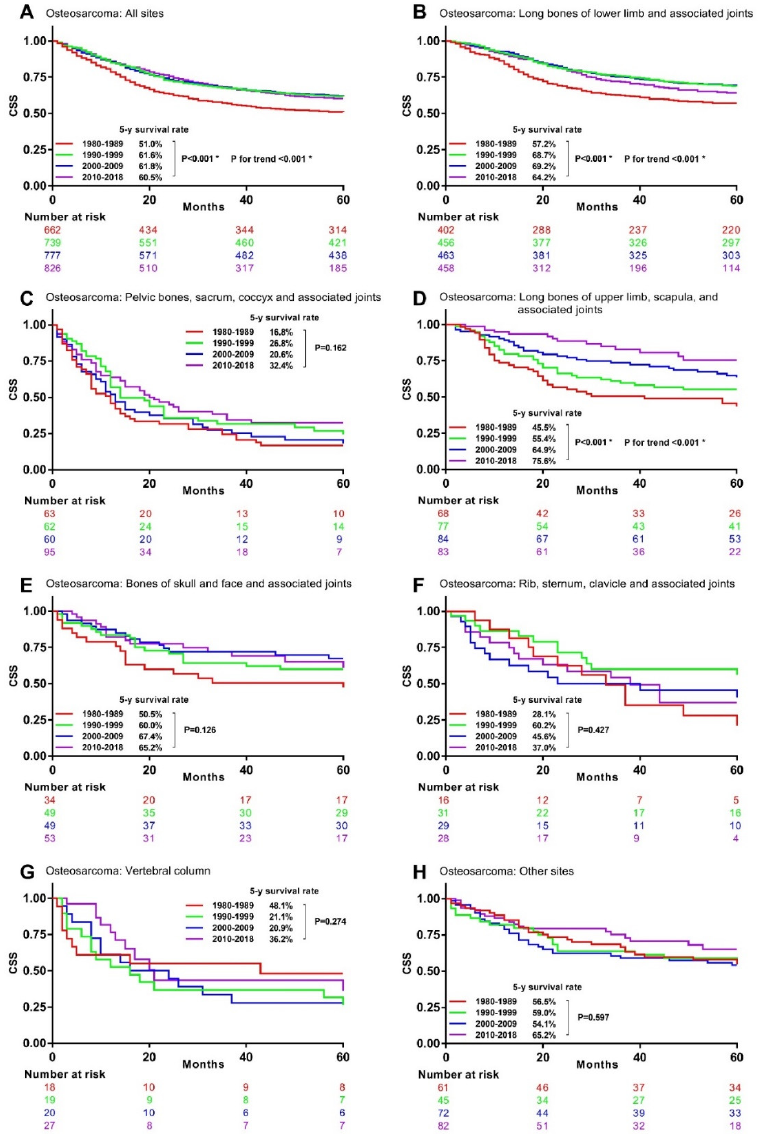
Figure 3. Kaplan–Meier curves showing 5-year CSS rates trend by decade in osteosarcoma with different primary sites. CSS: bone sarcomas-specific survival * Statistically significant. ( A ), All site ( B ), Long bones of lower limb and associated joints ( C ), Pelvic bones, sacrum, coccyx and associated joints( D ), Long bones of upper limb, scapula, and associated joints ( E ), Bones of skull and face and associated joints ( F ), Rib, sternum, clavicle and associated joints ( G ), Vertebral column ( H ) Other